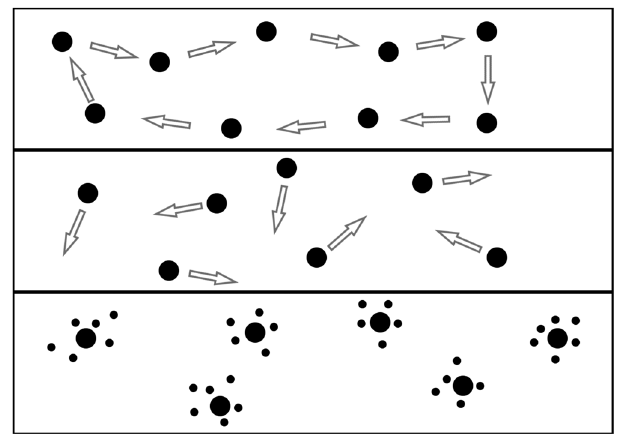
Figure 5: Three forms of cyclical movement ( drawing: Luka Bogdani ć )